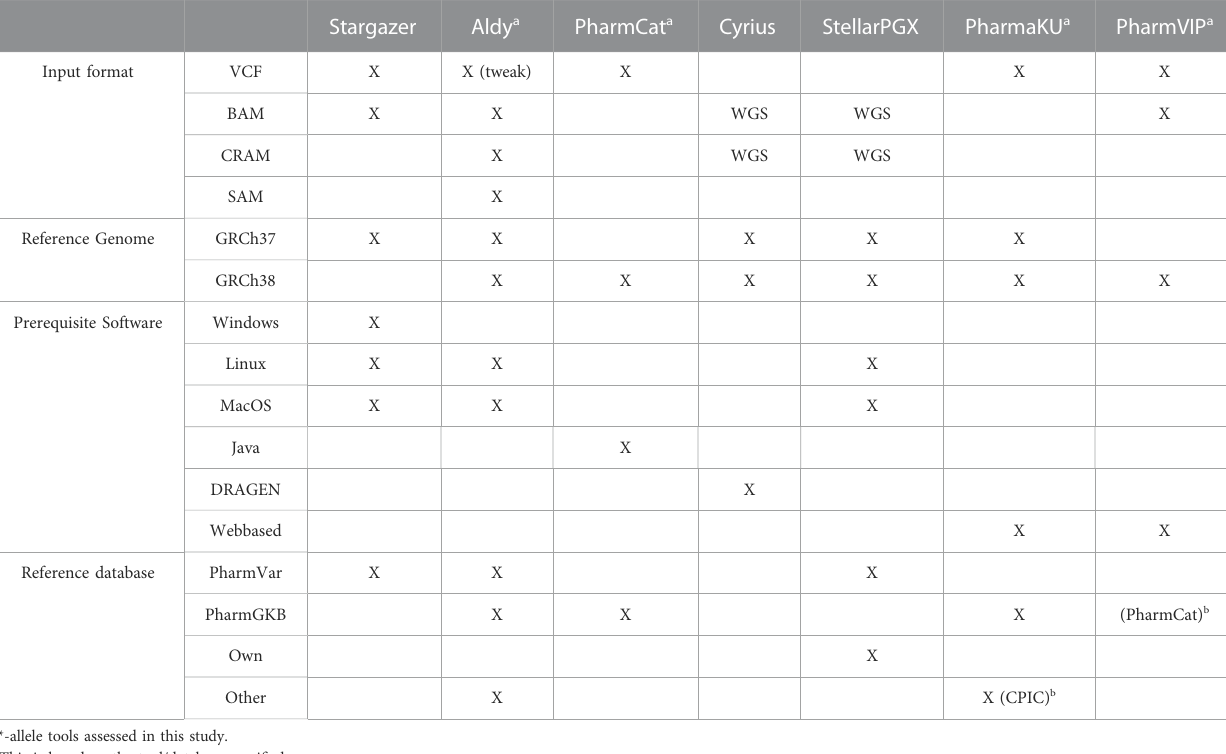
TABLE 1 Overview of *-allele tools and their speci fi cations. For every *-allele tool selected, the supported input fi le format(s), the used reference genome, the prerequisitesoftwareandthereferencedatabaseonwhichthe*-alleletoolanalysisisbasedaredepicted.When ‘ WGS ’ isstated,thesetoolsassumeinput fi leswith WGS data. ‘ Tweak ’ indicates that an adjustment was necessary before the *-allele tool supported this input fi